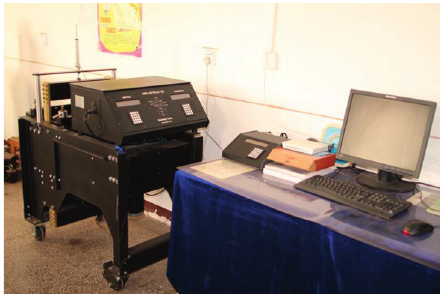
Figure 4: Triaxial compression apparatus LoadTrac-II/FlowTrac- II.